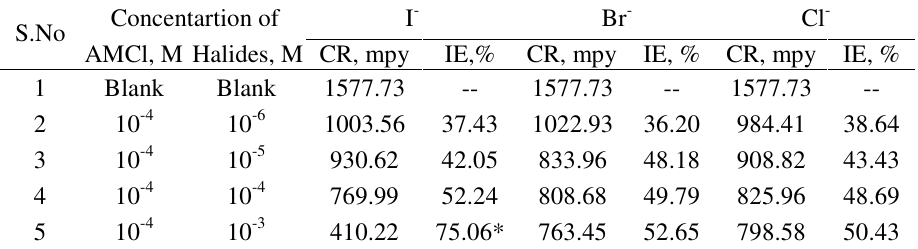
Table 4. Effect of various halides on the corrosion inhibition of MS in the presence